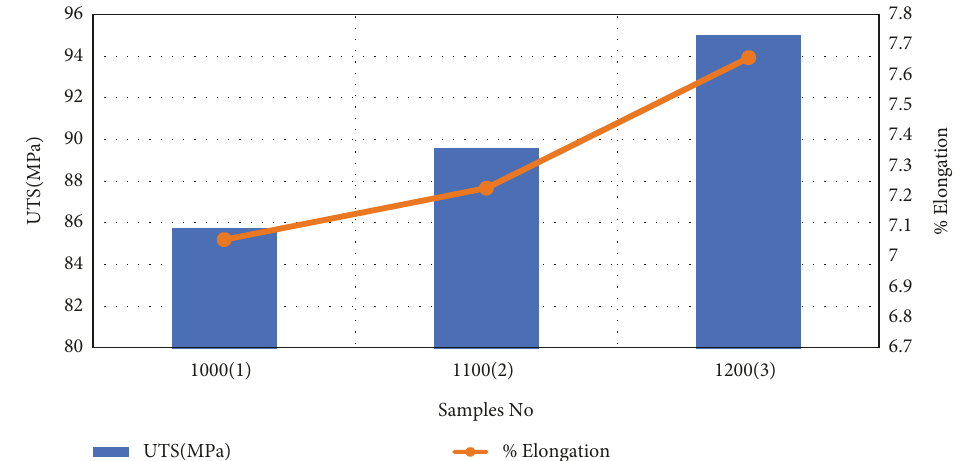
Figure 17: Samples vs. UTS (MPa) and % elongation.